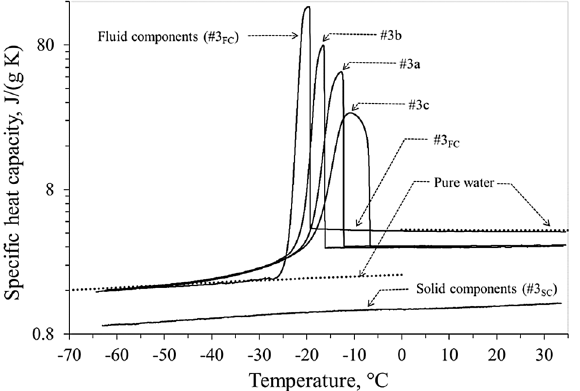
Figure 5. Measured specific heat capacity of liver samples #3a, #3b, and #3c, fluid (#3 FC ) and solid (#3 SC ) components, obtained with constant cooling rate of 5 K/min. Dotted lines refer to pure water values found in literature 29